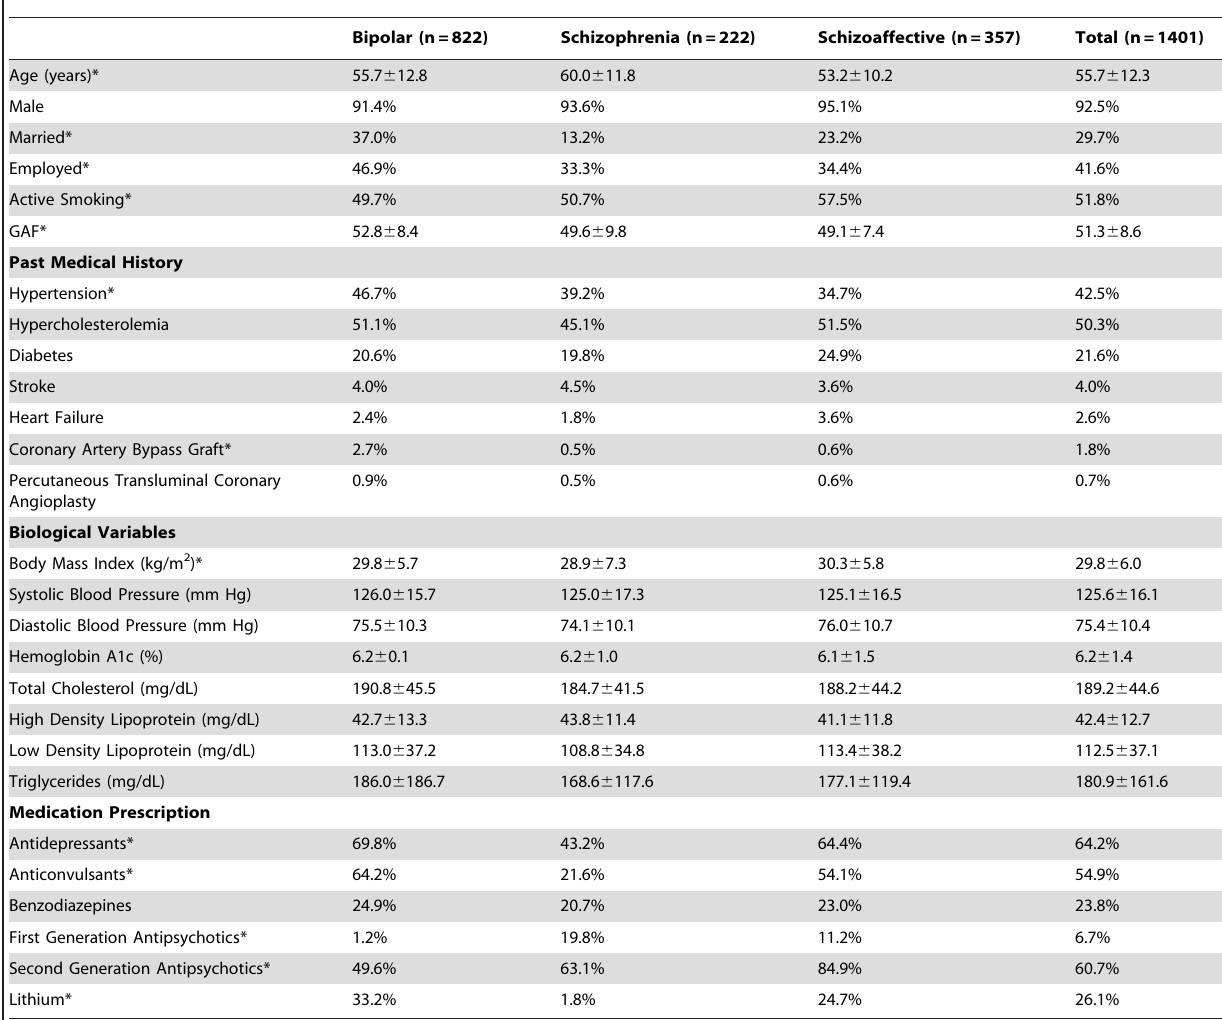
Table 1. Patient